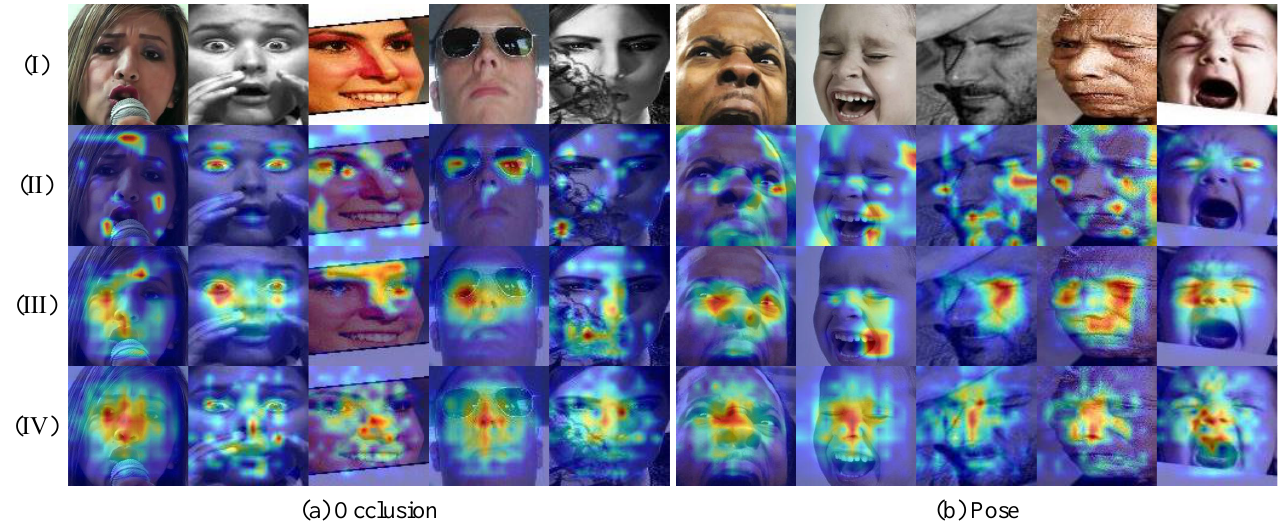
Figure 8. The comparisons of Grad-CAM visualization for different configurations of our method on occlusion and pose datasets. The lighter colors, the stronger Grad-CAM areas are covered. In both ( a , b ): (I) Raw images; (II) Base (using layer-3 of the backbone); (III) Backbone + SWC + LFE; (IV) Backbone + SWC + LFE + AFS.